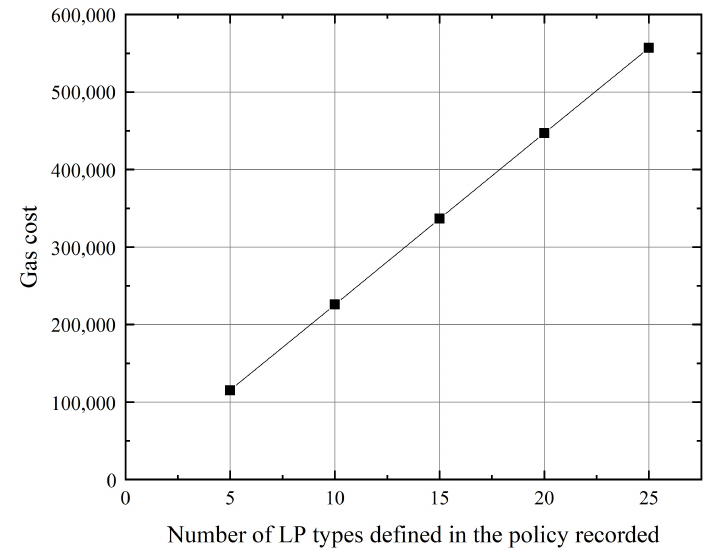
Figure 13. Gas cost of LP recording policy.